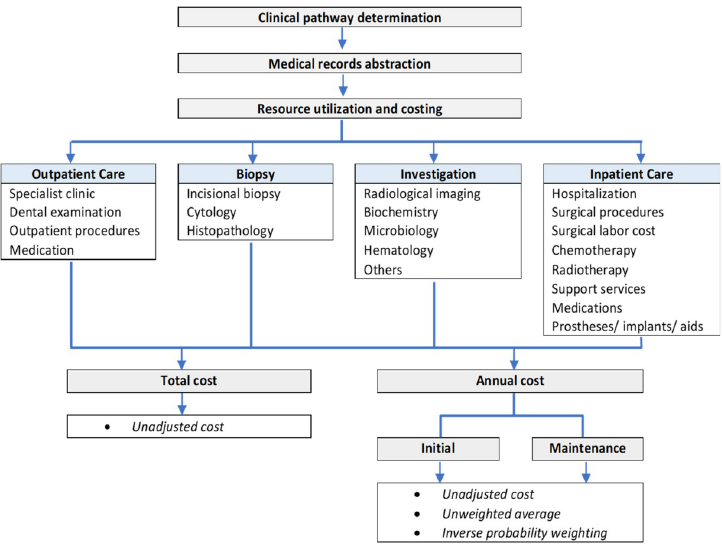
Fig 1. Study framework to determine the cost of treating OPMD and oral